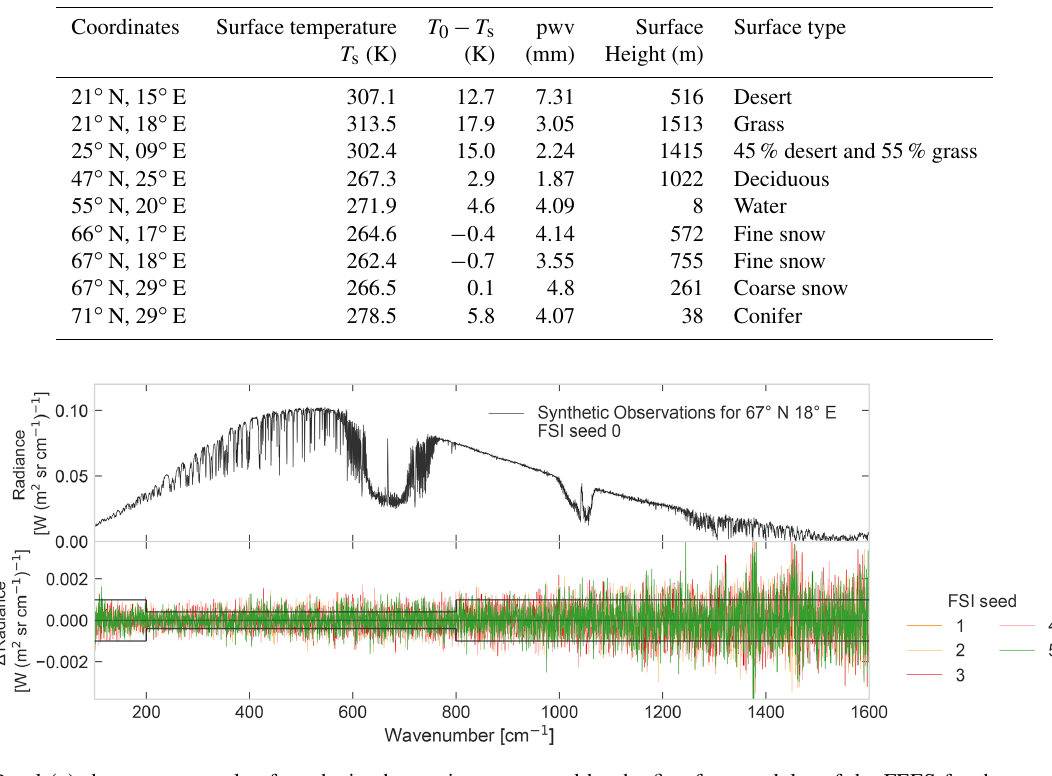
Figure 2. Panel (a) shows an example of synthetic observations generated by the first four modules of the FEES for the scene at 67 ◦ N, 18 ◦ E on 15 January 2018 at 12:00UTC. Panel (b) shows the difference in radiance between spectra generated with the FORUM Sounding Instrument (FSI) random noise seeds from 1–8 and the spectrum generated with seed 0 (shown in panel a ). The FORUM goal noise equivalent spectral radiance (NESR) is shown as the black lines in panel (b)